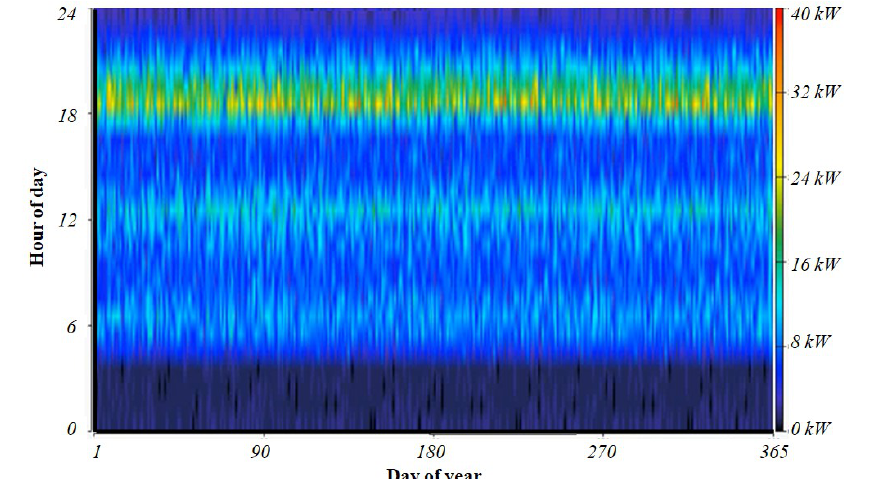
Figure 7. Yearly average total electrical load served at the village.